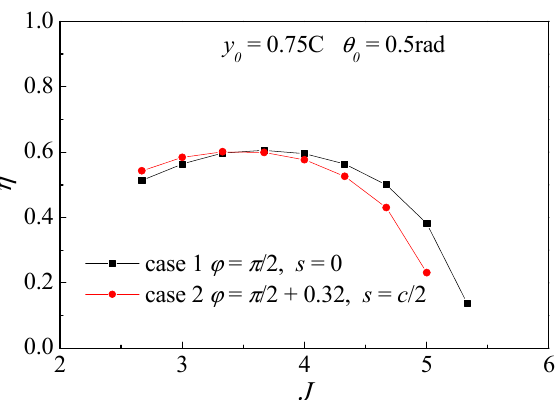
Figure 15. Comparison of propulsive efficiency between the Case 1 and Case 2.